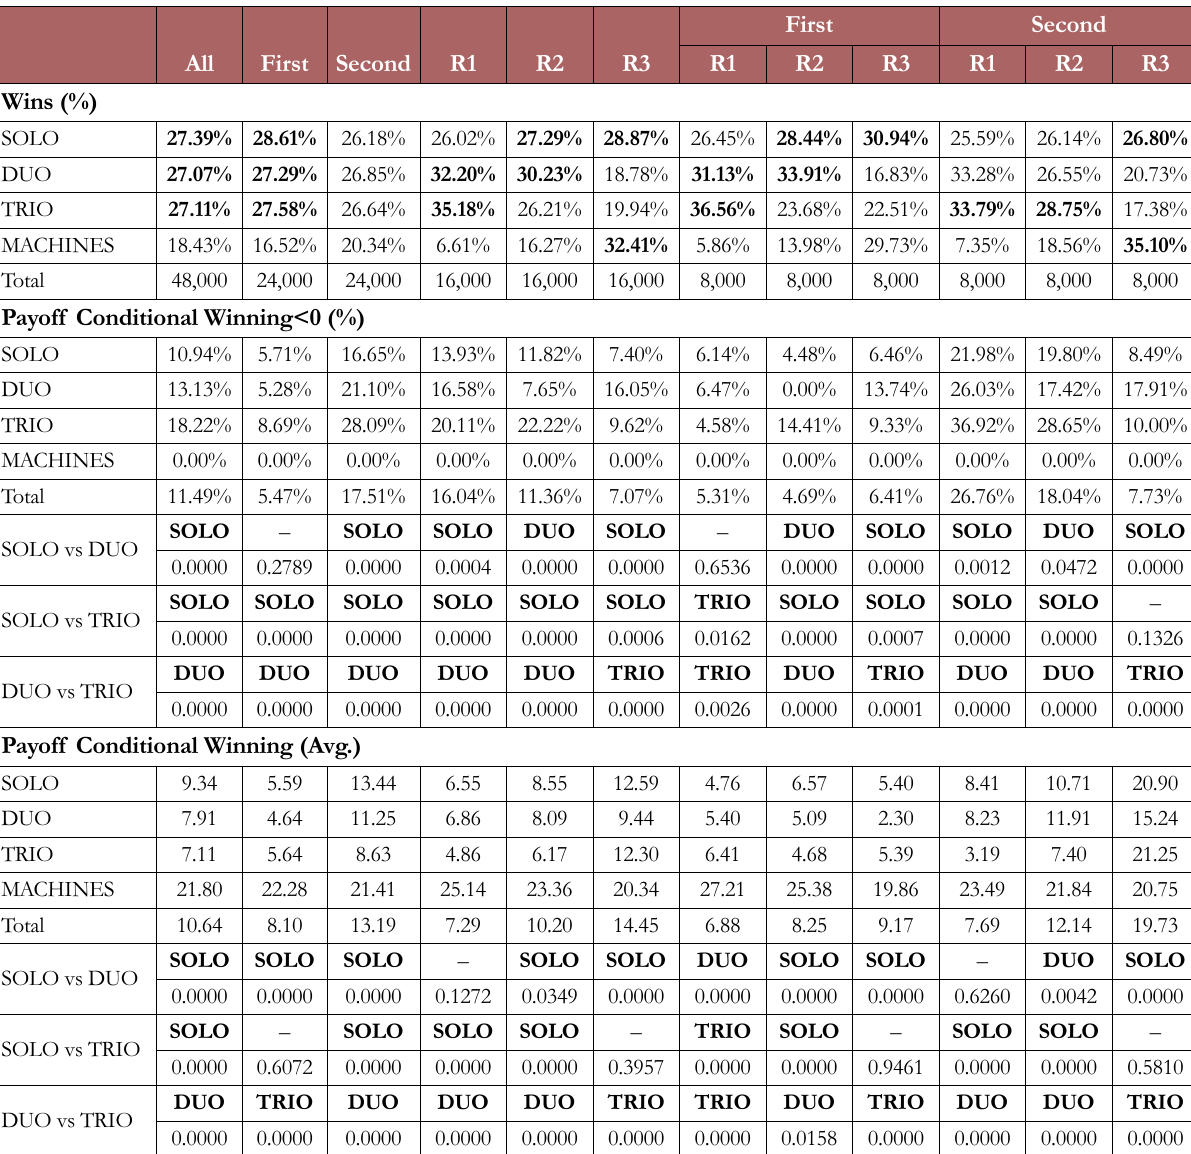
Table A2.6. Influence of machines and payoffs: pairwise differences in terms of size by right and mechanism